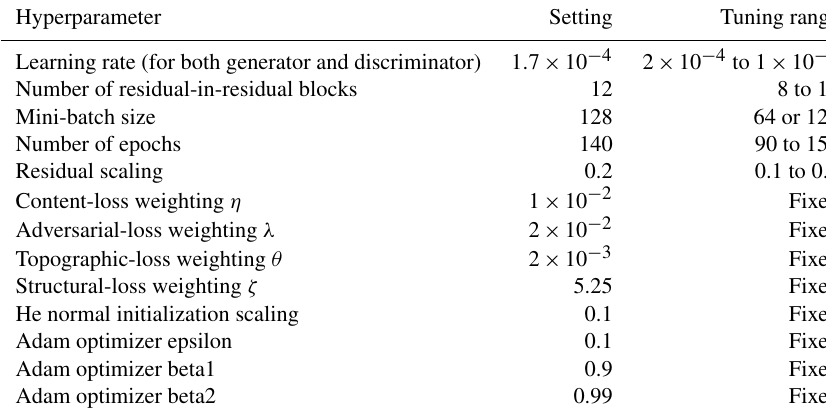
Table B1. Optimized hyperparameter